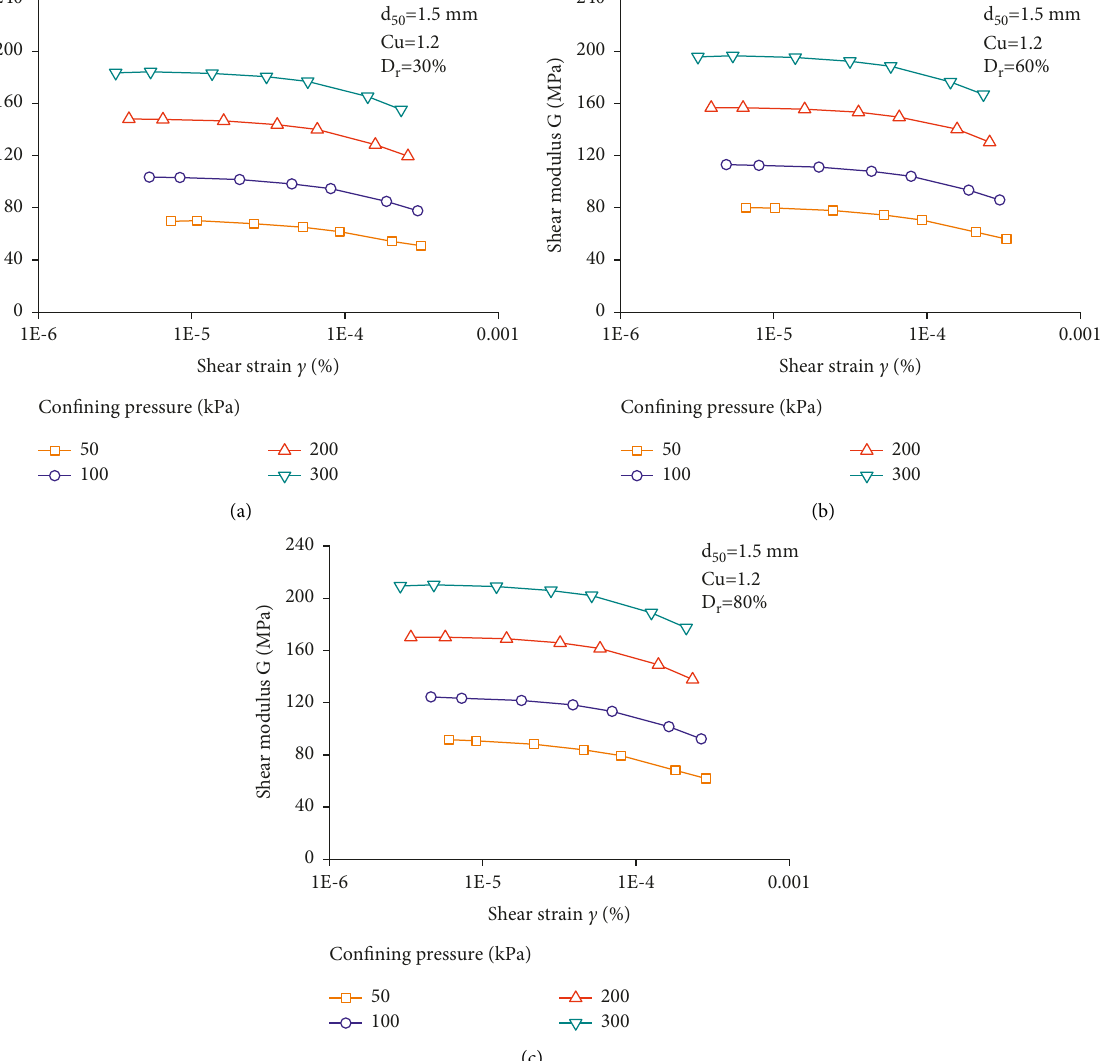
� 1.5mm and Cu � 1.2 at different confining pressures. (a) Loose 50